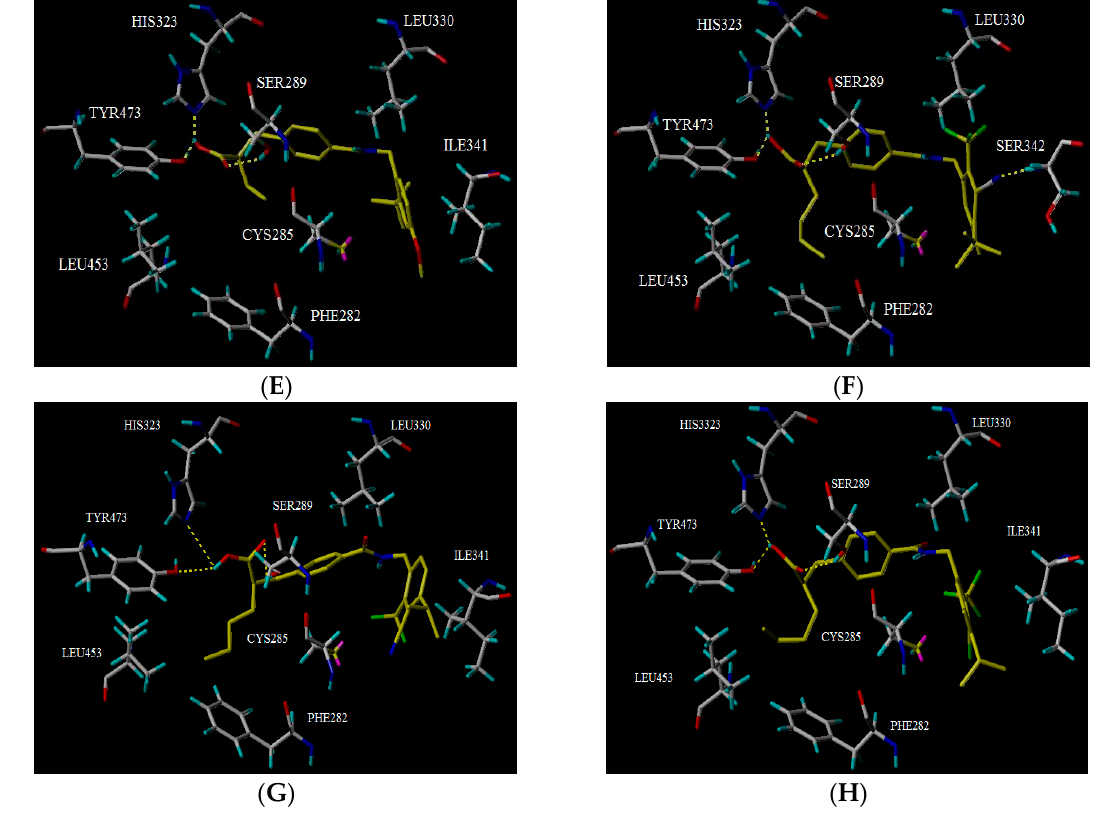
Figure 4. Docking results. ( A ) The surface of the binding site, and the conformation comparison of compound 24c (yellow), the original ligand (purple), and the key residues (white) at the binding site; ( B ) The surface of the binding site and the comparison of the conformation of, compound N1 (yellow), the original ligand (purple), and the key residues (white), at the binding site; ( C ) The surface of the binding site, and the comparison of the conformation of compound N9 (yellow), the original ligand (purple), and the key residues (white), at the binding site; ( D ) The surface of the binding site, and the comparison of the conformation of compound N12 (yellow), the original ligand (purple), and the key residues (white), at the binding site; ( E ) Interaction between compound 24c (yellow) and residues (white); ( F ) Interaction between compound N1 (yellow) and residues (white); ( G ) Interaction between compound N9 (yellow) and residues (white); ( H ) Interaction between compound N12 (yellow) and residues (white).